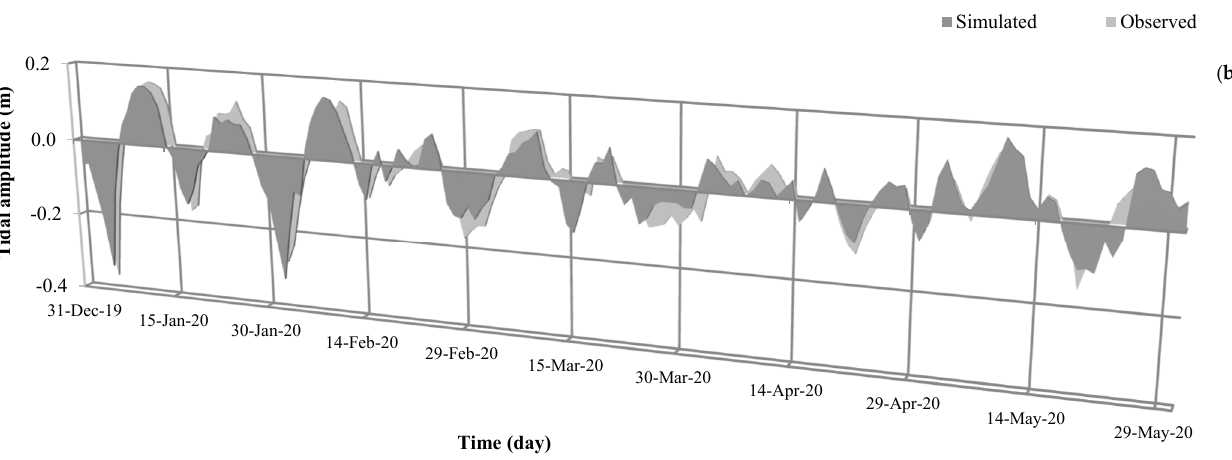
Figure 4. Time series of daily simulated and observed amplitudes in both 2019 ( a ) and 2020 ( b ) at Long Xuyen station. Table 3. Summary of correlation coefficient (R), Nash–Sutcliffe efficiency (NSE) and root mean square error (RMSE) of water levels in the dry season (Jan–May) in 2019 and 2020 at Long Xuyen station.